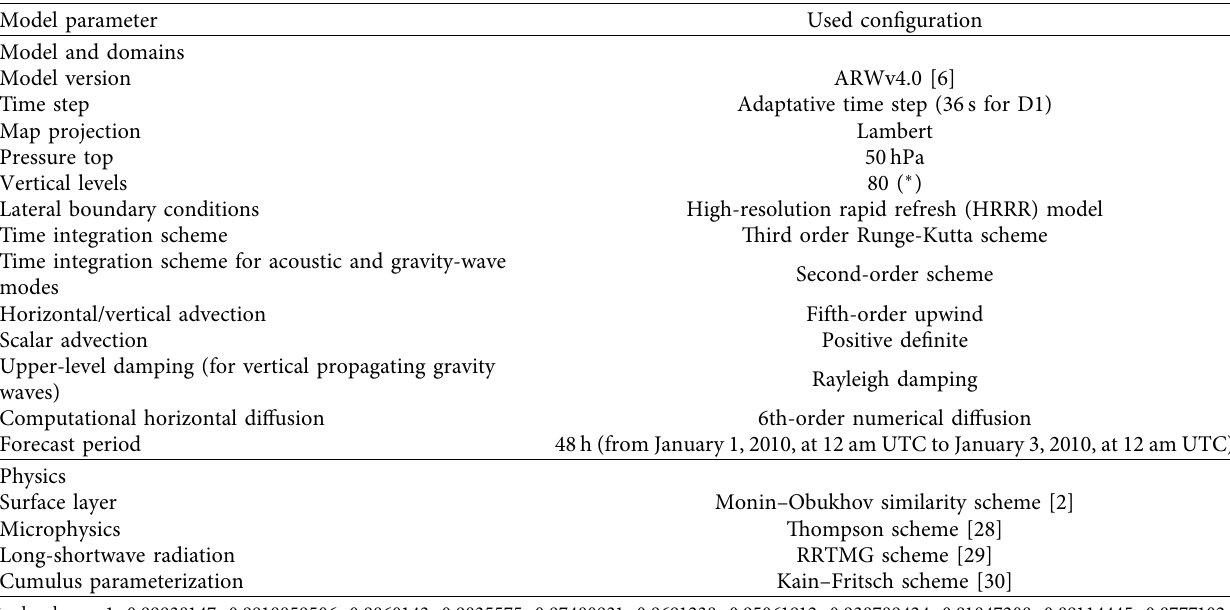
Table 3: WRF model configuration and input physics